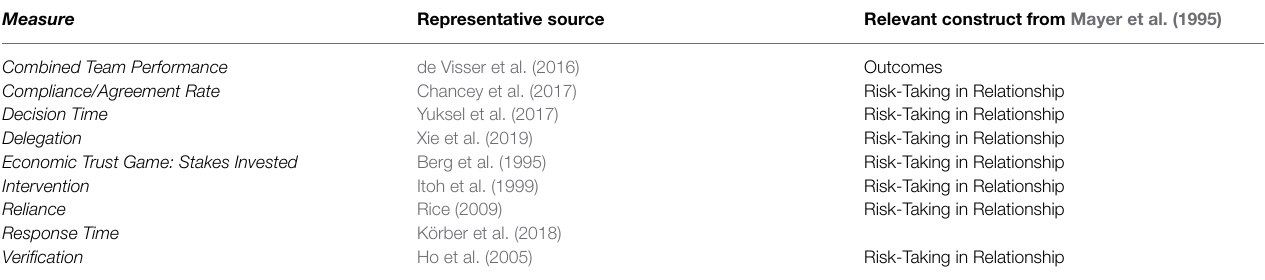
TABLE 4 | Behavioral measures of